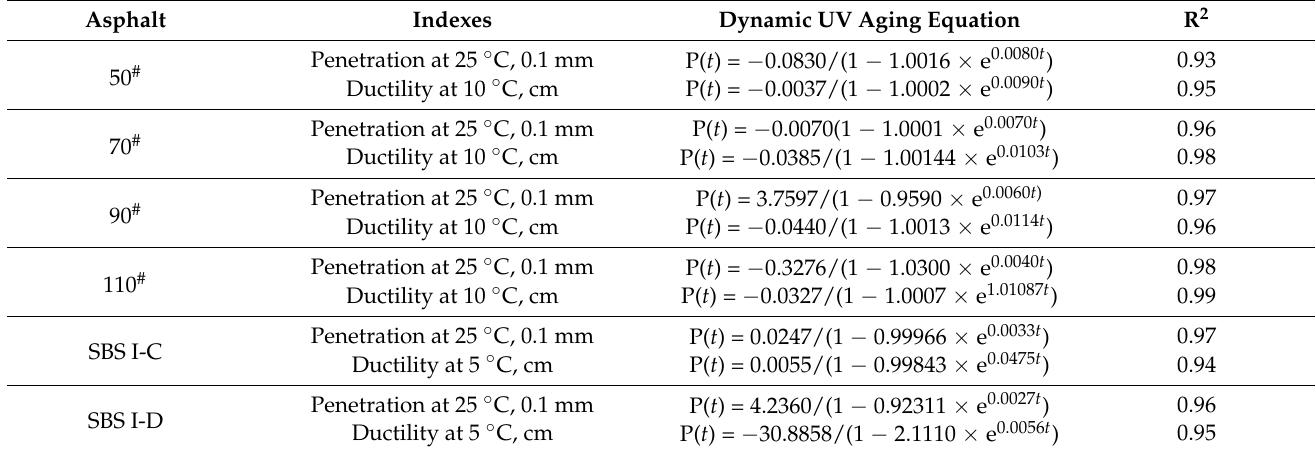
Table 2. UV aging equations of various asphalt involved in this